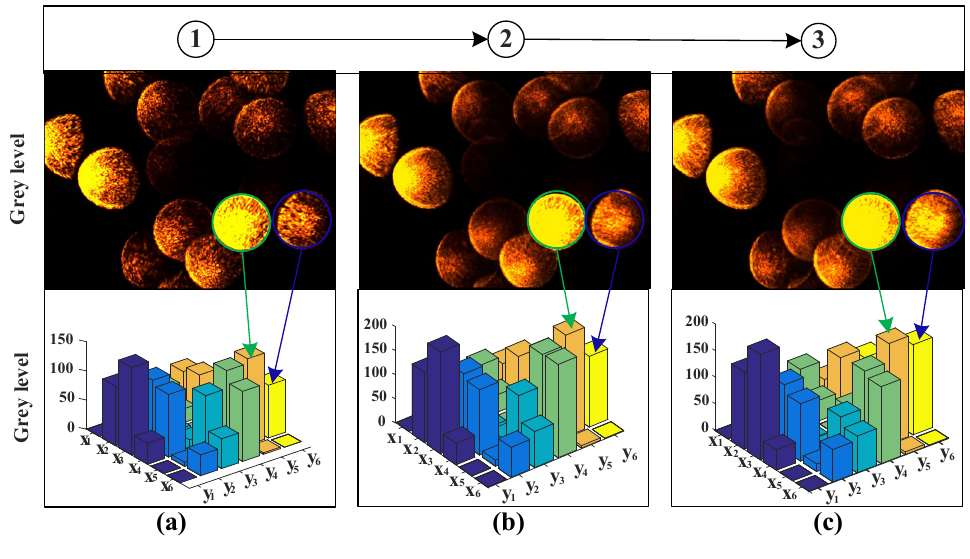
Figure 6. Gray values change examples with the tool displacement in x-direction. ( a ) grey level of point 1 in Figure 5, ( b ) grey level of point 2 in Figure 5, ( c ) grey level of point 3 in Figure 5. The AC servo motor in the y-direction was driven in steps of 1 µm in a range of 0–120 µm. Figure 7 shows the output in terms of gray values vs. tool displacement change